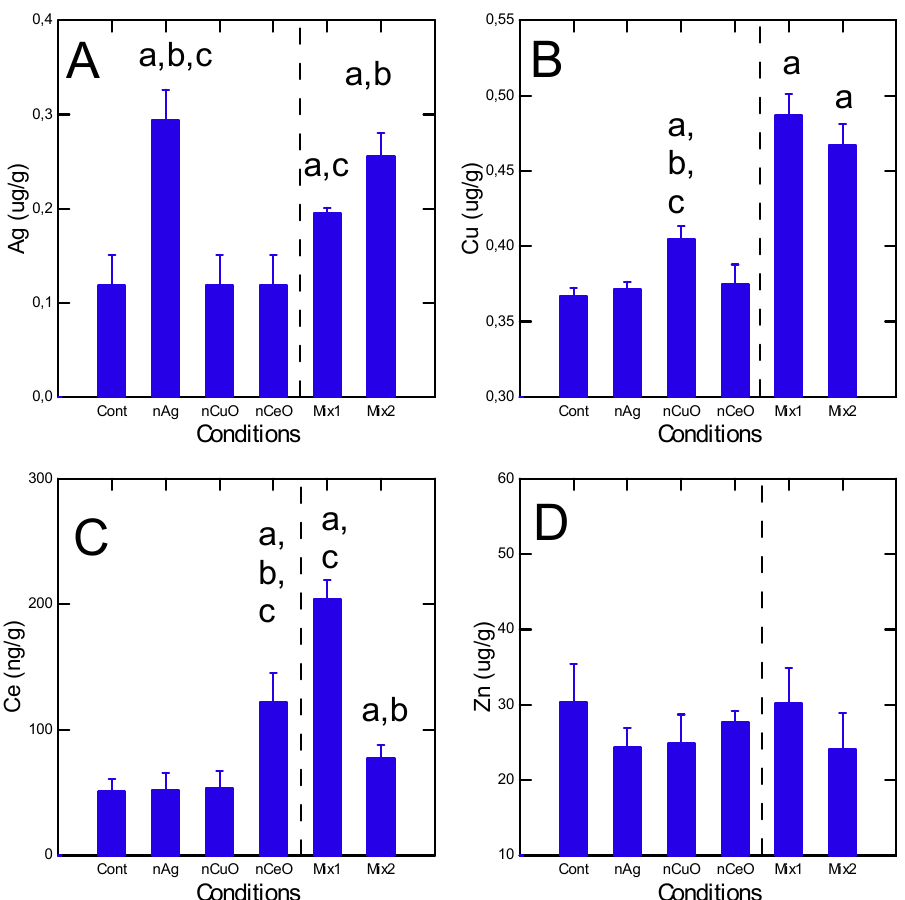
Figure 1. Metal uptake in fish exposed to nanoparticles and mixtures. The data represent the mean with the standard error for Ag ( A ), Cu ( B ), Ce( C ) and Zn ( D ). The Mix1 consists of 20 μ g/L of nAg and nCuO and 5 μ g/L of nCeO giving a net concentral of 45 μ g/L. The Mix2 consists of 50 μ g/L of nAg and nCuO and 10 μ g/L nCeO giving a net concentration of 110 μ g/L. The letter a indicates significance relative to controls, b significance relative to Mix1, and c relative to Mix2.